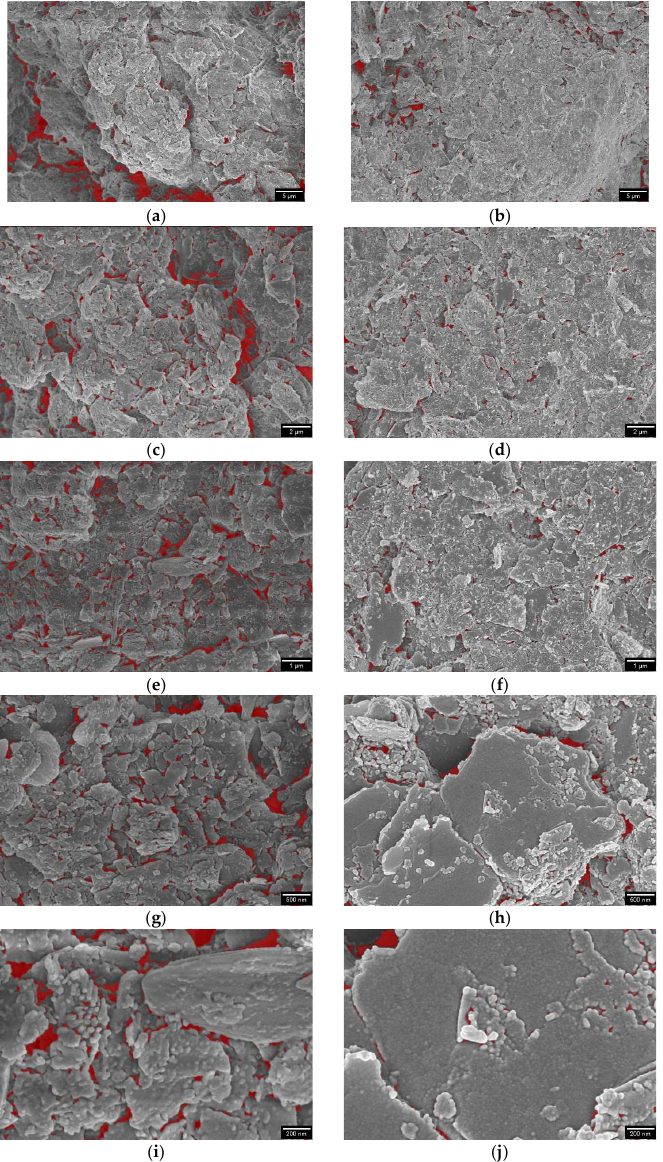
Figure 8. Scanning electron micrographs.( a ) 2000 × glacial till; ( b ) 2000 × 0.35 L/m 3 F1 stabilized soil; ( c ) 5000 × glacial till; ( d ) 5000 × 0.35 L/m 3 F1 stabilized soil; ( e ) 10,000 × glacial till; ( f ) 10,000 × 0.35 L/m 3 F1 stabilized soil; ( g ) 20,000 × glacial till; ( h ) 20,000 × 0.35 L/m 3 F1 stabilized soil; ( i ) 50,000 × glacial till; ( j ) 50,000 × 0.35 L/m 3 F1 stabilized